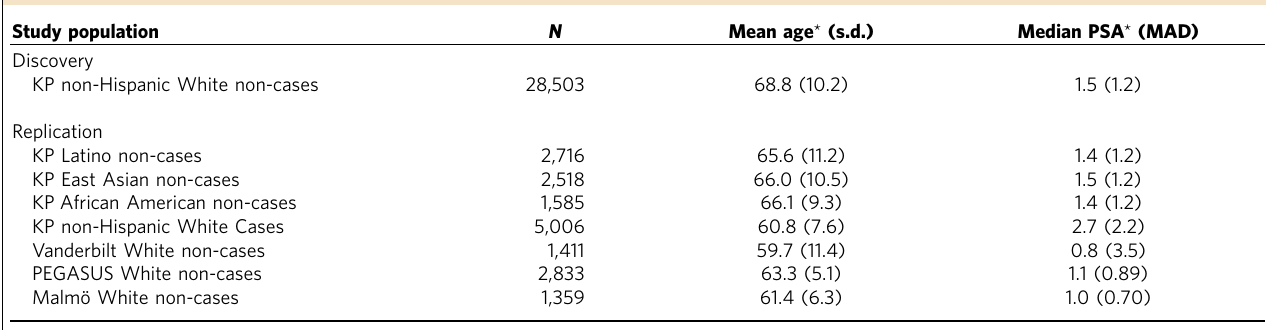
Table 1 | Sample size, age and PSA levels of subjects included in discovery GWAS and replication studies. Study population N Mean age *